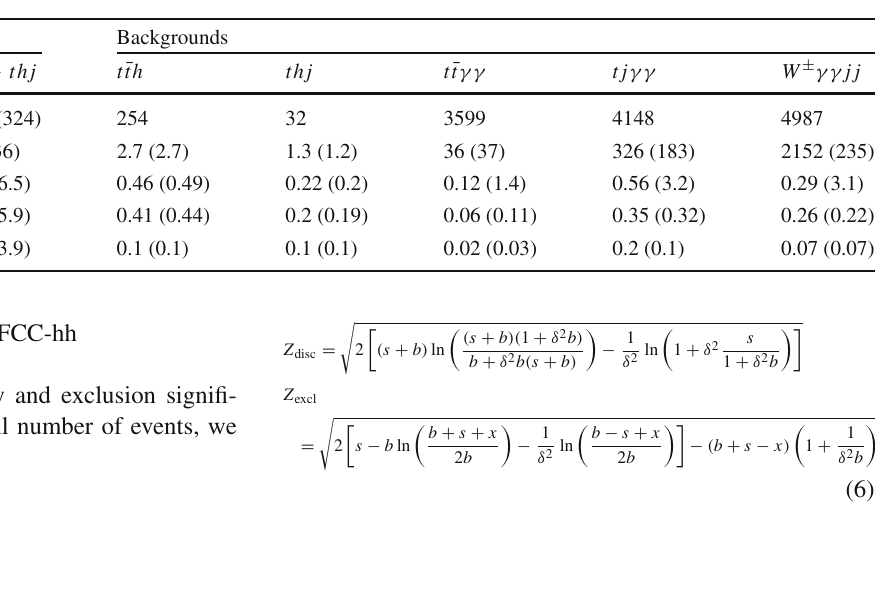
Fig. 3 Normalised distributions for the signals and SM backgrounds at the HE-LHC Table 2 The cut flow of the cross sections (in ab) for the signals and SM backgrounds at the HE-LHC with κ tuh = 0 . 04 and κ tch = 0 . 04 (in the